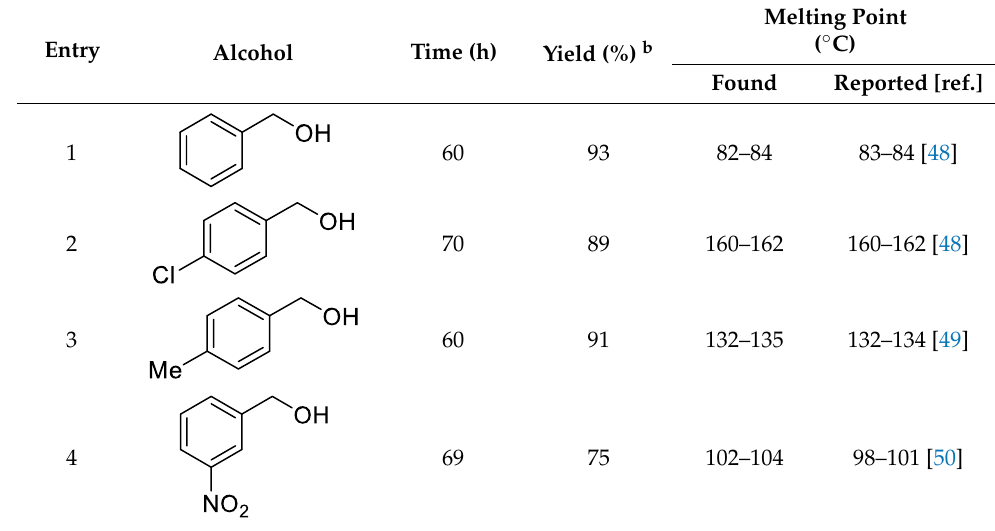
Melting Point ( ◦ C) Found Reported [ref.]